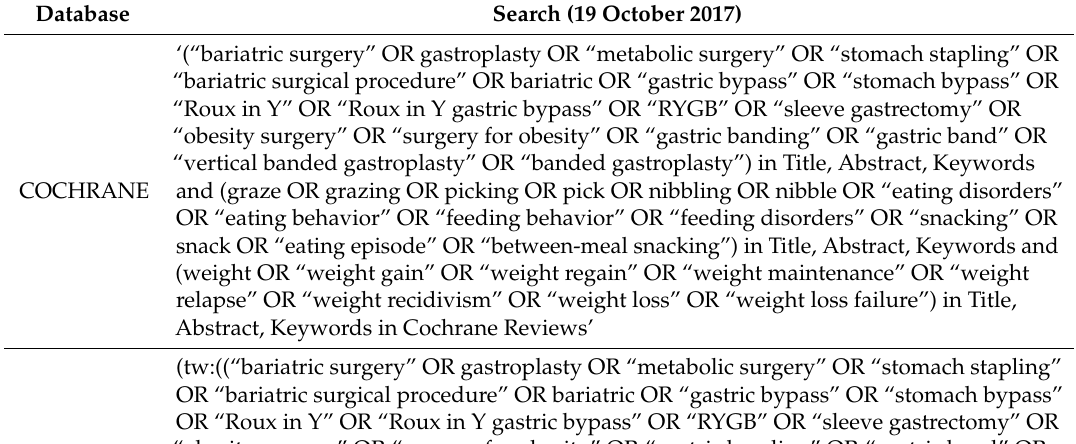
Table A2. Database search